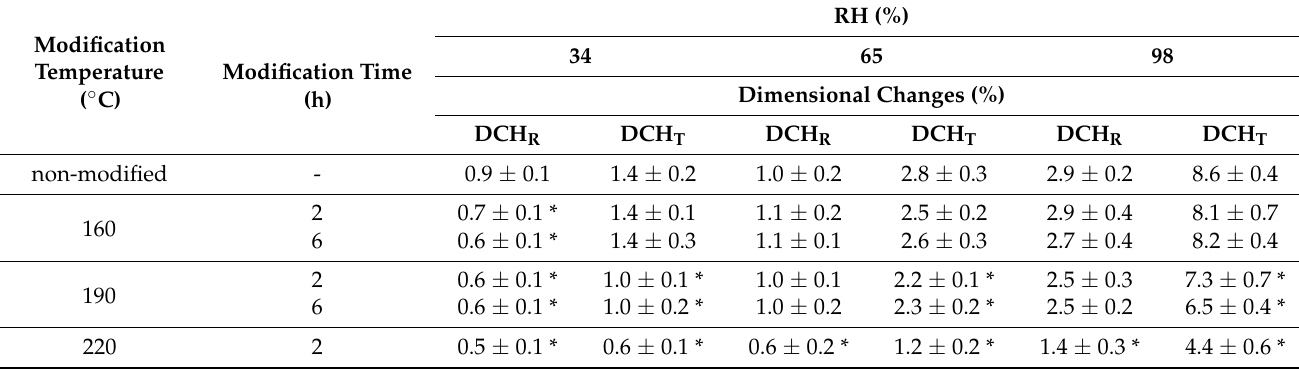
Table 5. Dimensional changes in radial (DCH R ) and tangential (DCH T ) directions of black poplar, non-modified and thermally modified in nitrogen atmosphere, during humidification at different relative humidities (RH); ± (SD).